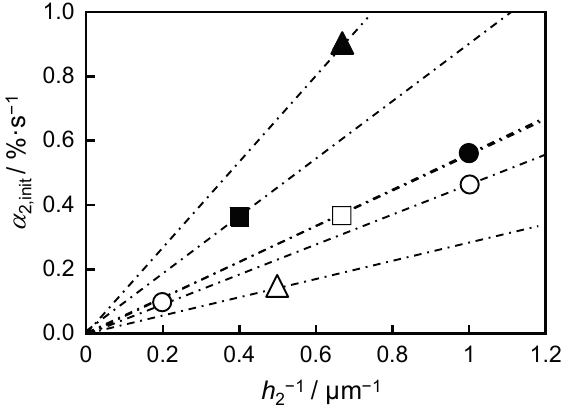
Figure 6. Relationship between α 2,init and h 2 − 1 in diarylethenes 1 ( ○ ), 2 △ ( ), 3 ( ● ), 4 ( ■ ), 5 ( ▲ ), and 6 ( □